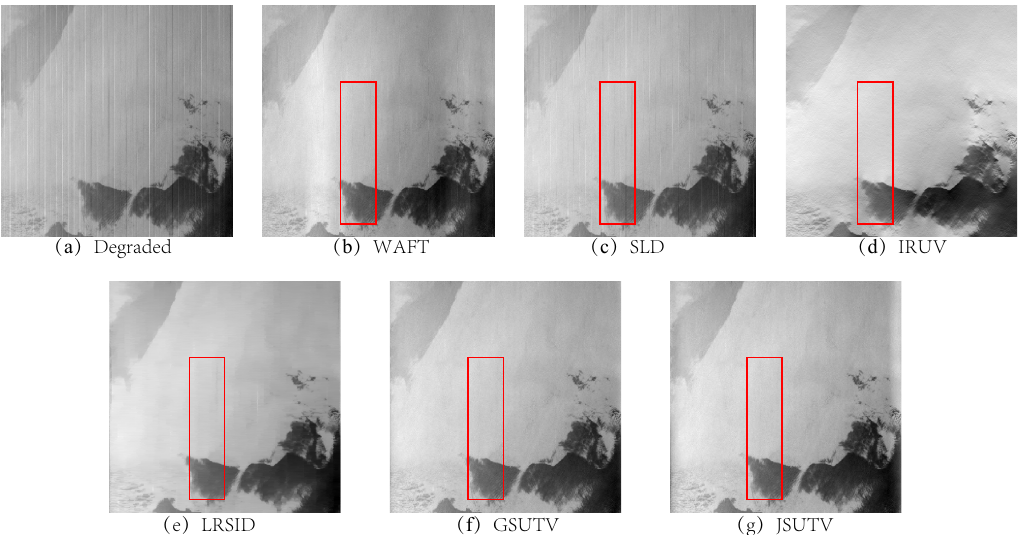
Figure 10. Destriping results of the Terra MODIS image. ( a ) Degraded image; destriping images by: ( b ) WAFT; ( c ) SLD; ( d ) IRUV; ( e ) LRSID; ( f ) GSUTV; ( g )